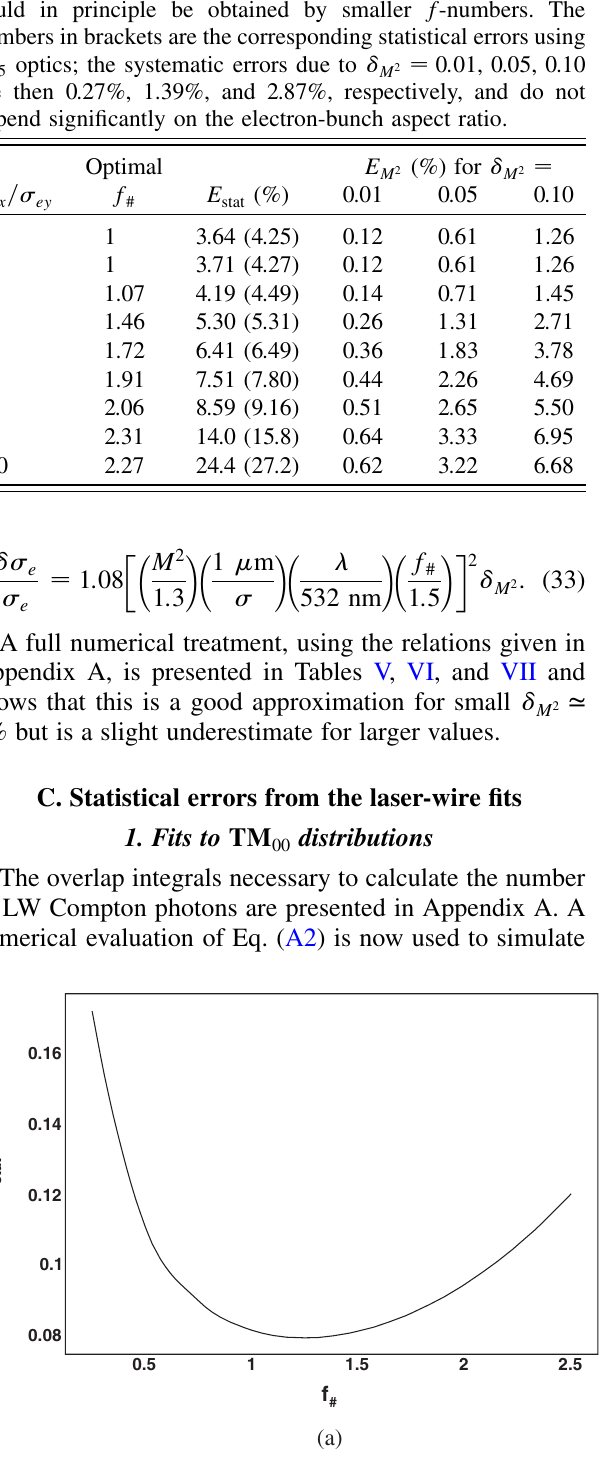
FIG. 15. (a) Statistical error E final-focus lens, using a laser with M 2 (cid:1) 1 : 3 and operating in the TM have a Gaussian transverse profile with (cid:2)